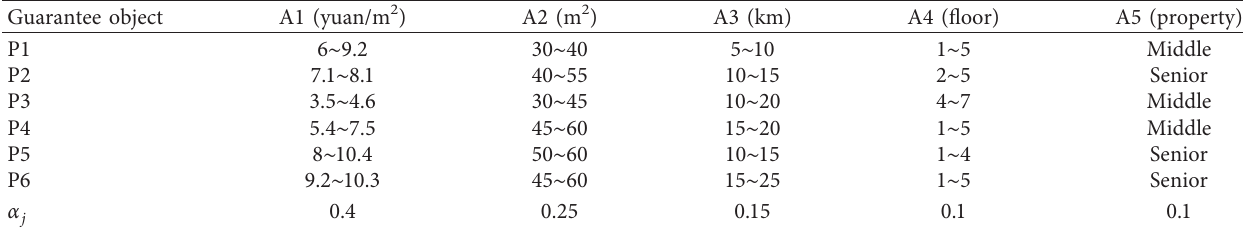
Table 2: The expectation level of a group of 6 security objects for the public housing